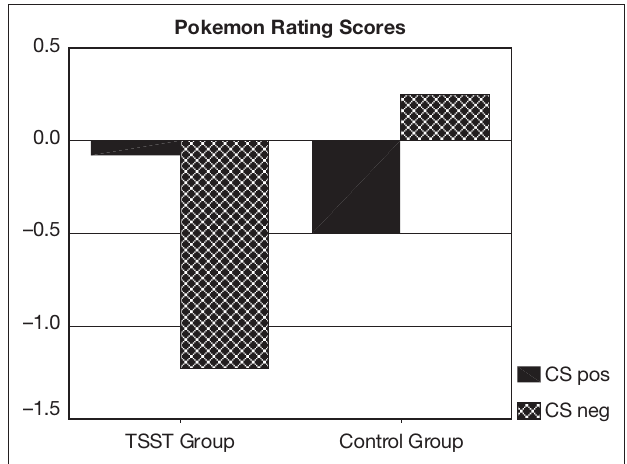
FIGURE 1 | Pokemon rating scores for CS pos and CS neg in stressed and control